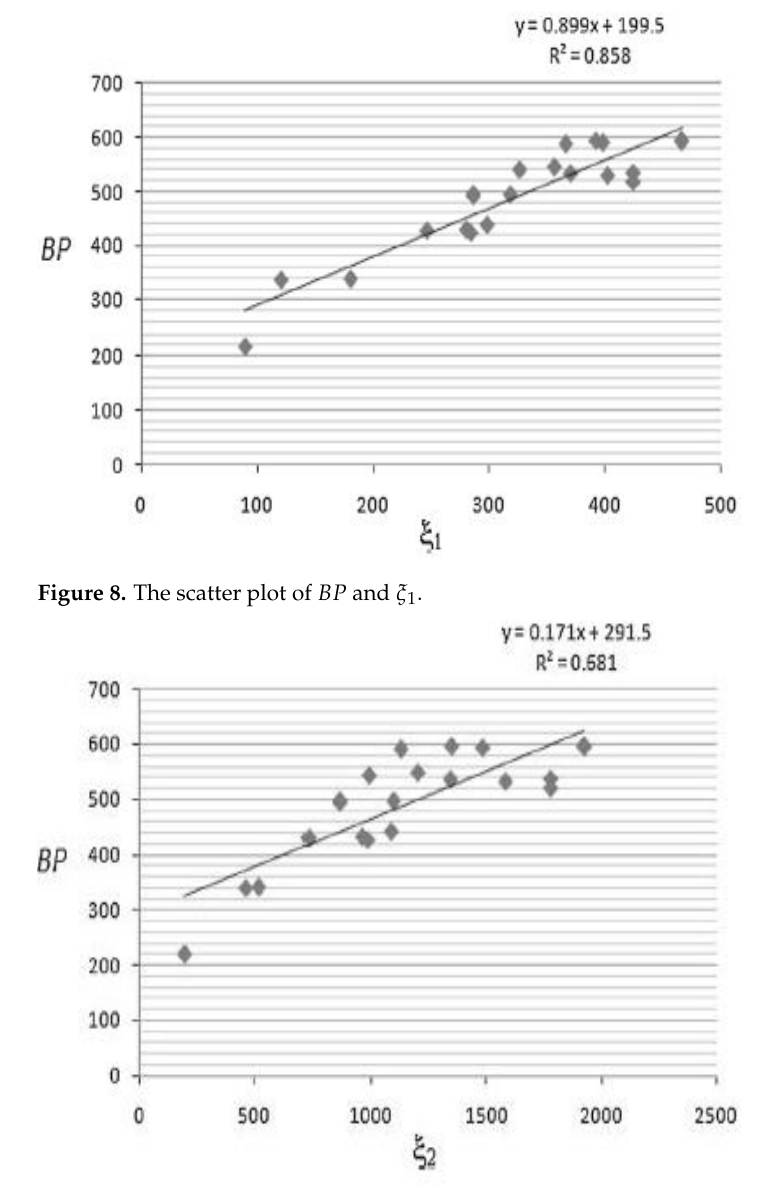
Figure 9. The scatter plot of BP and ξ 2 . Table 1. Different values of BP, ξ 1 and ξ 2 of 21 benzenoid